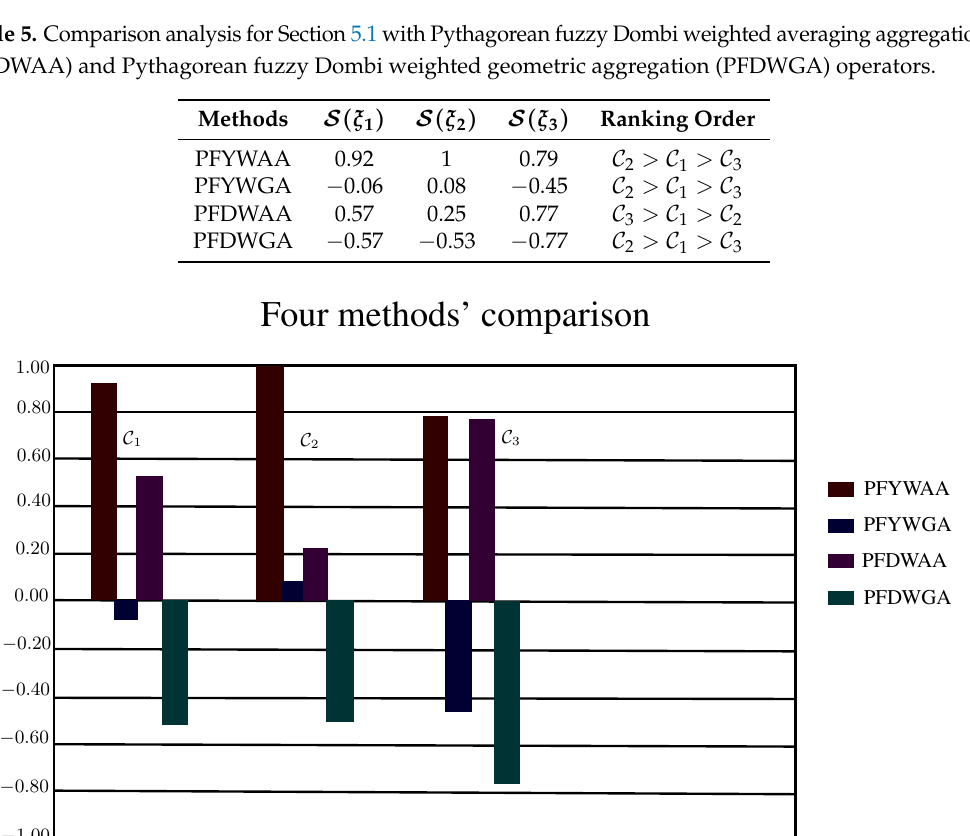
Table 5. Comparison analysis for Section 5.1 with Pythagorean fuzzy Dombi weighted averaging aggregation